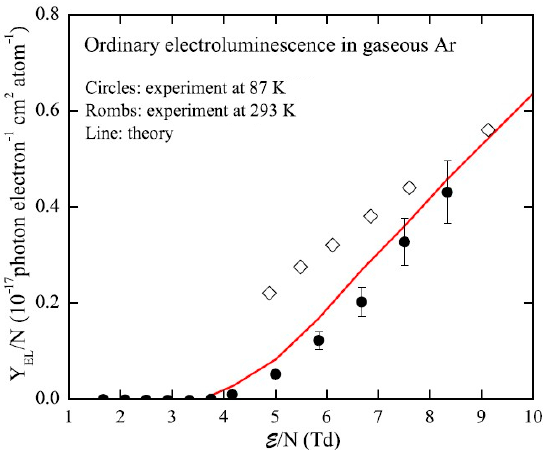
Figure 11. Reduced EL yield in gaseous Ar as a function of the reduced electric field, for ordinary EL (due to excimer emission in the VUV) near its threshold, measured at 87 K [9] and at 293 K [14] (from [9], with permission from Elsevier). The theoretical calculation of [16] is also shown.